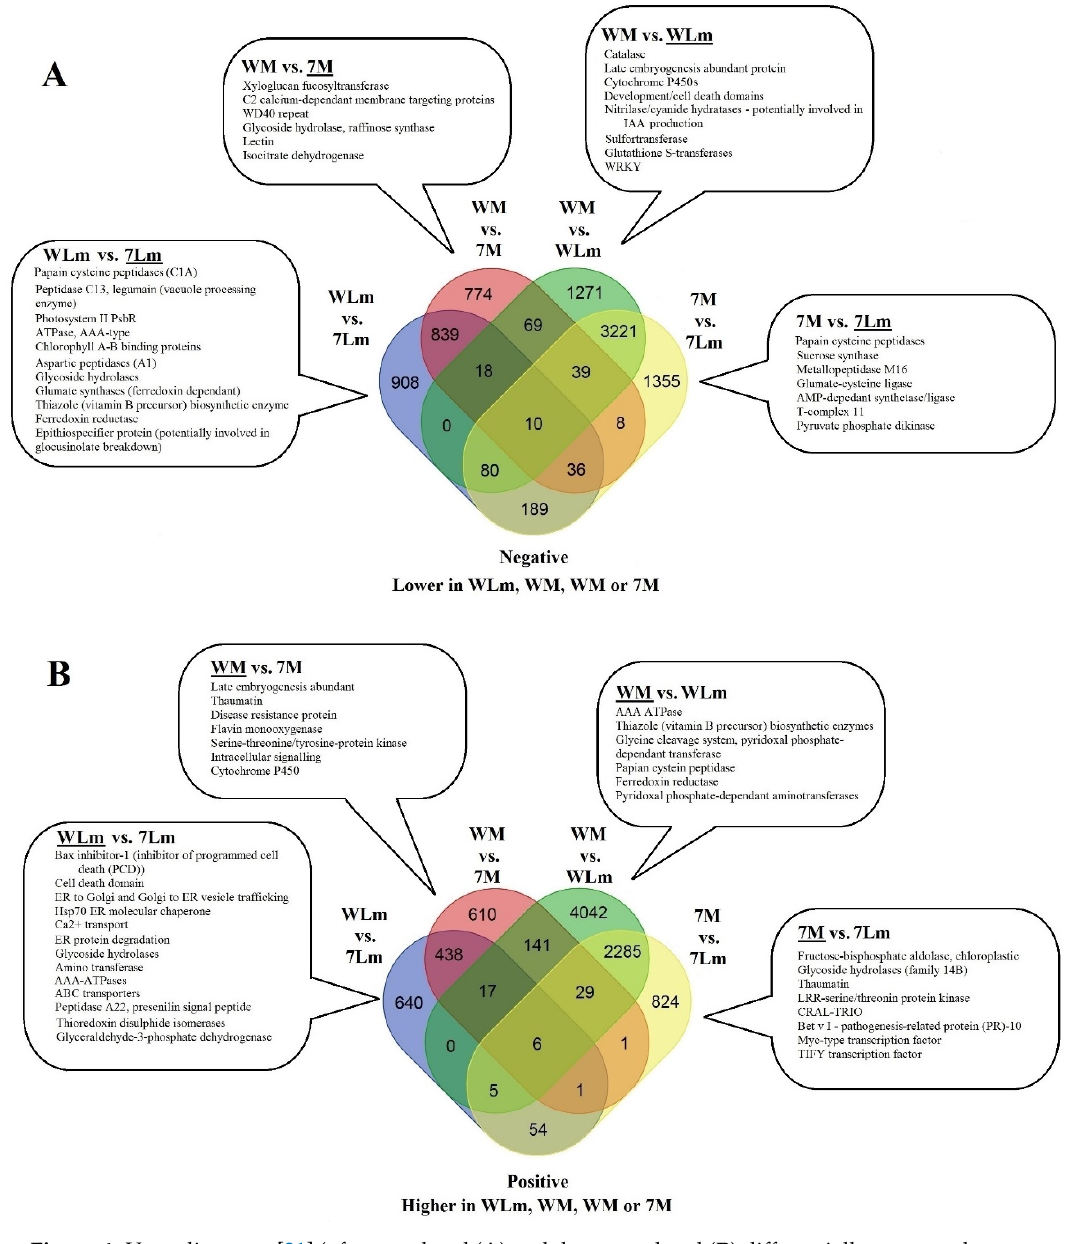
Figure 4. Venn diagrams [31] (of upregulated ( A ) and downregulated ( B ) differentially expressed genes (DEGs) between L. maculans inoculated Westar (WLm) and 74-44 BL (7Lm), mock-inoculated Westar (WM) and 74-44 BL (7M), and between mock and inoculated Westar or mock and inoculated 74-44 BL. Genes associated with the underlined treatment are upregulated significantly in the paired comparisons.